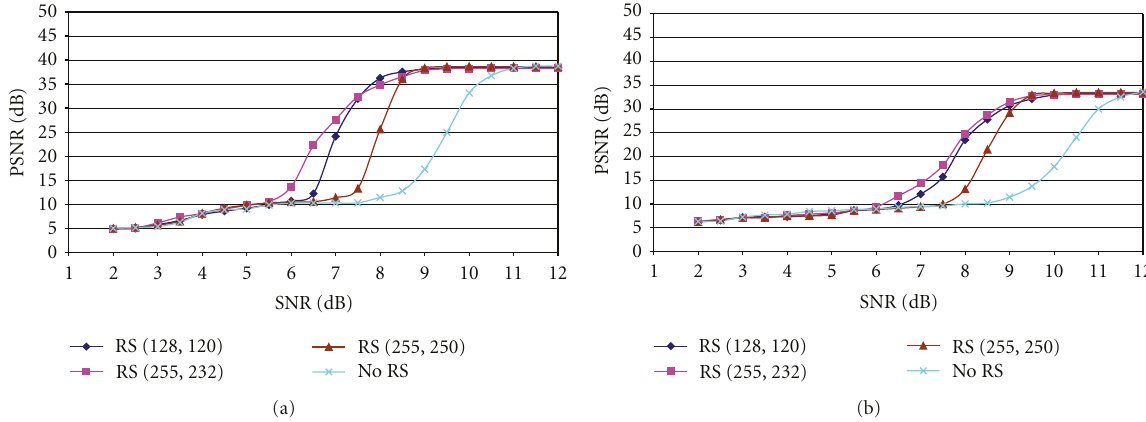
Figure 14: PSNR evolution for “HallMonitor” and “Mobile Calendar” sequences in CIF resolution over BSC channel for di ff erent protection levels with RS codes.